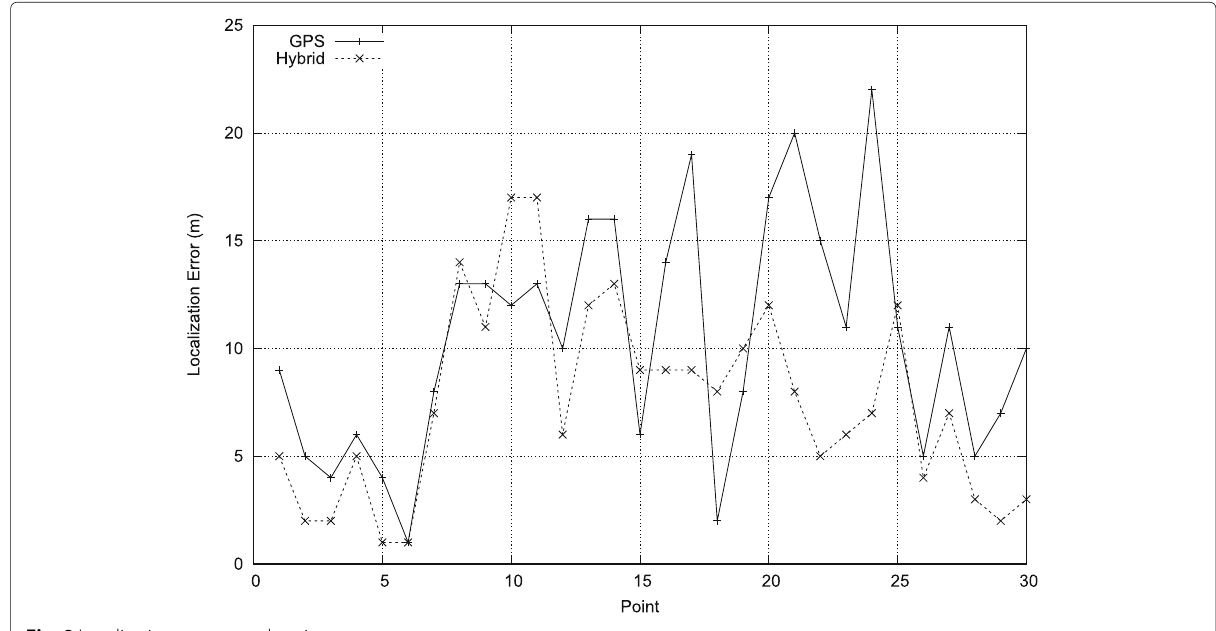
Fig. 8 Localization error at each